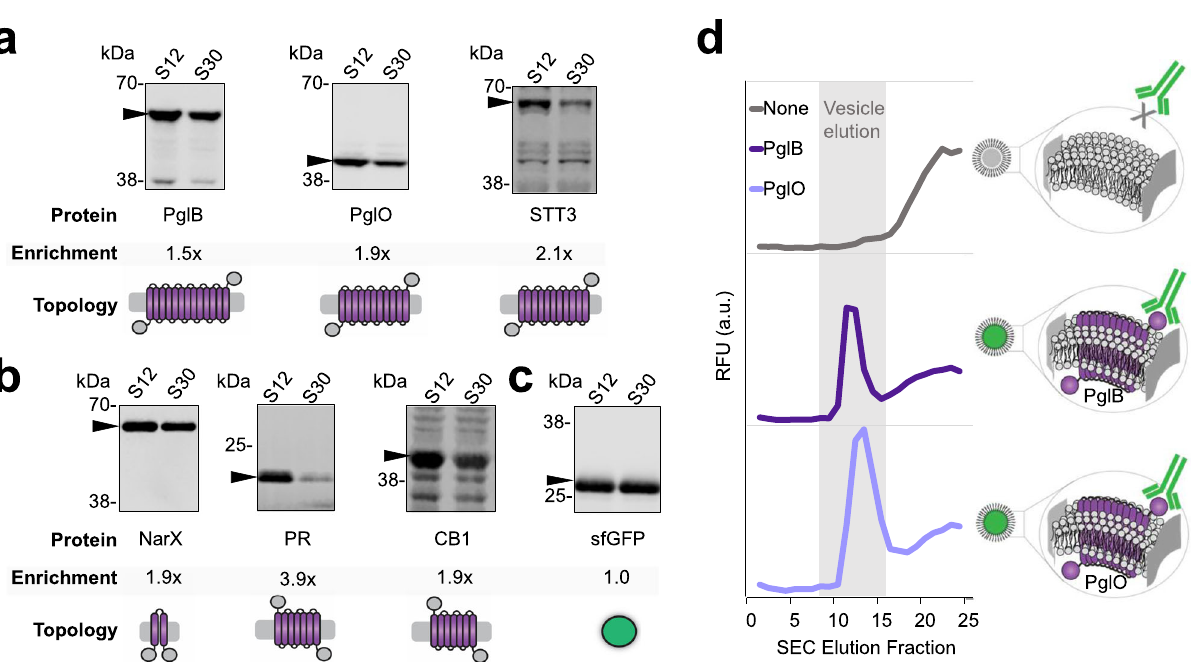
Fig. 4 Heterologous membrane-bound cargo can be controllably enriched via membrane vesicles. Enrichment of heterologous membrane proteins in S12 and S30 extracts was quantitated using α -FLAG western blots against the heterologous proteins for: a glycosylation enzymes, b signal transduction proteins, and c a cytosolic sfGFP control with no transmembrane helices. On each western blot, left lanes are S12 extracts and right lanes are S30 extracts. Black arrows indicate the membrane protein of interest. Molecular weight (kDa) from protein ladder standards are indicated to the left of each blot. Protein names and enrichment ratios of bands (S12/S30) are shown directly below each blot. All blots are representative of n = 3 biologically independent extracts. Cartoons depict the transmembrane topology for each protein. See Supplementary Table 1 for taxonomical origin, transmembrane topology, functions(s), theoretical size, and UniProt ID. Full western blot images for panels ( a – c ) are available in Supplementary Fig. 6 and Source Data fi le. d Fluorescence chromatograms of SEC analysis of extracts probed with a fl uorescent α -FLAG antibody. Strains used to prepare extracts were enriched with no membrane protein (gray trace), PglB (dark purple trace), or PglO (light purple trace). Characteristic vesicle elution fraction from 3 independent experiments is highlighted in gray. Source data for all panels are provided as a Source Data fi